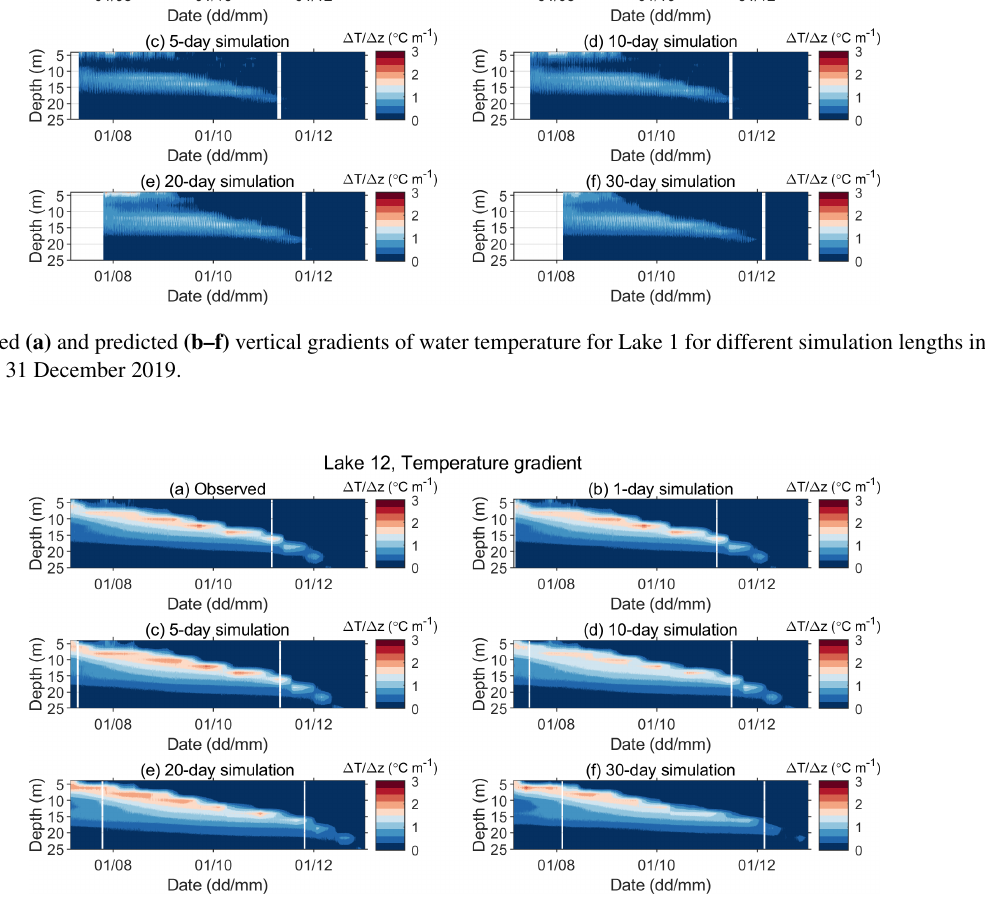
Figure A4. Observed (a) and predicted (b–f) vertical gradients of water temperature in Lake 12 for different simulation lengths in the period between 6 July and 31 December